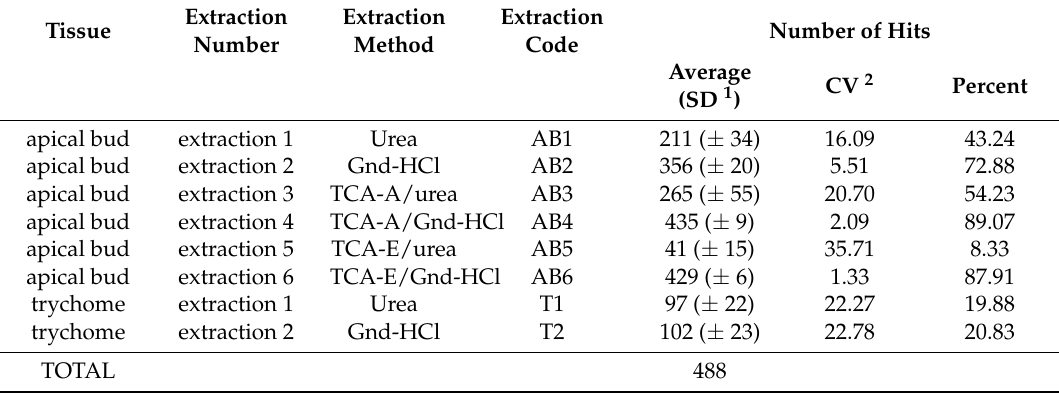
Table 2. Number of peptides identified by bottom-up proteomics with Xcorr